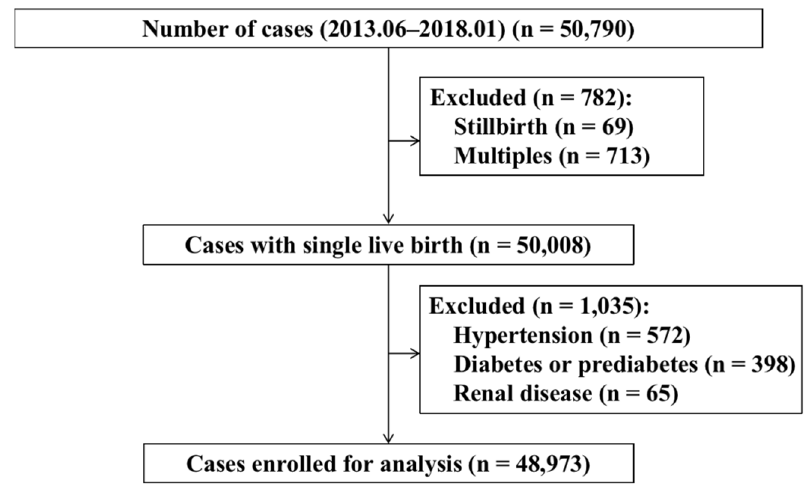
Figure 1. Flowchart for the study population.